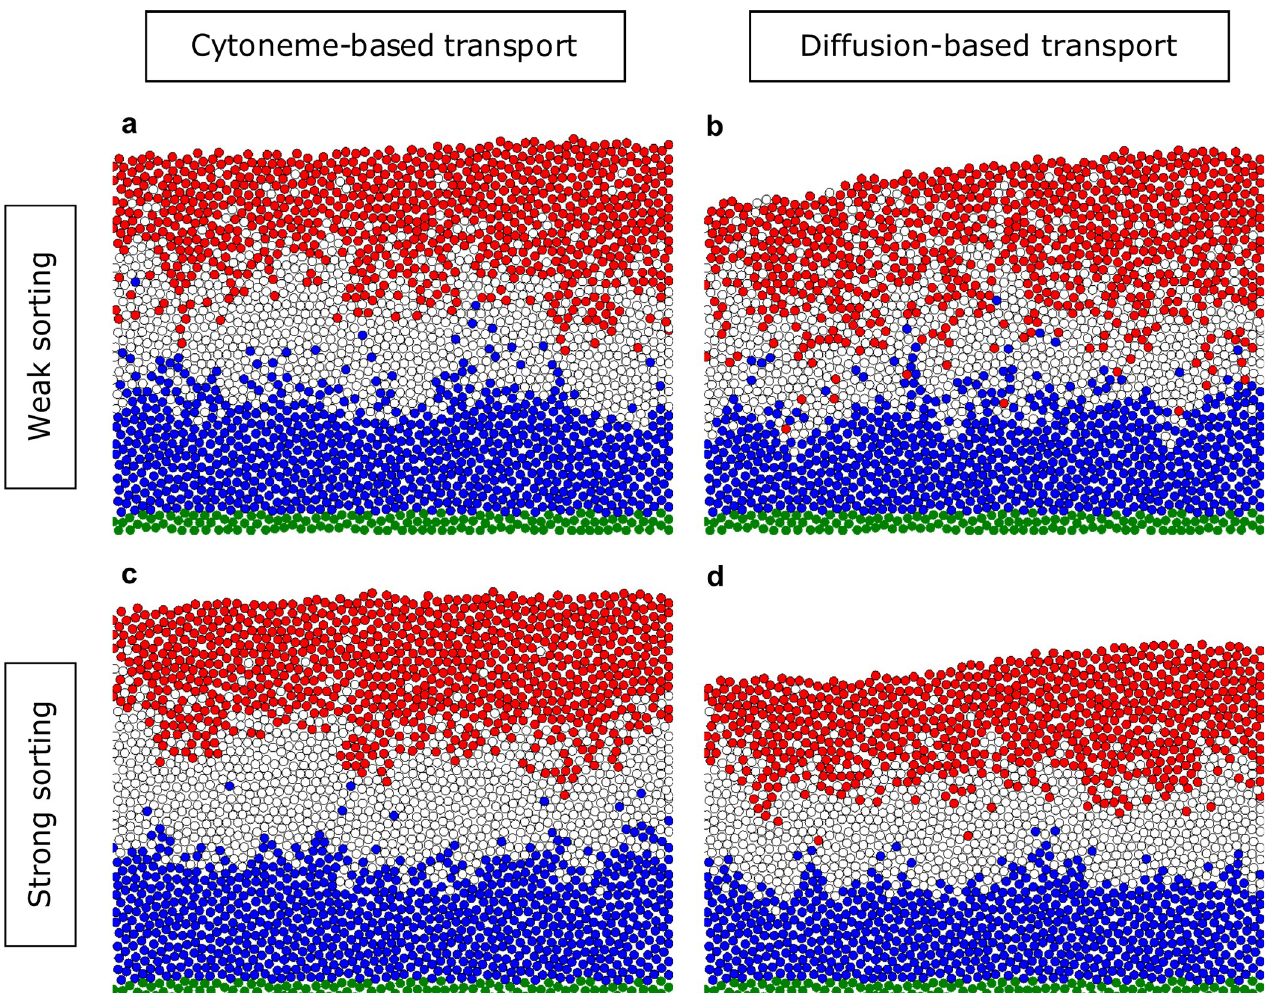
Fig 3. Boundary sharpening through directed migration. Distributions of the final cell fate at t = t TRS = 180 min in the tissue for different parameters of the cell dynamics and different transport mechanisms. Directed migration with the sorting parameter p DirMig = 0.02 is shown in a) and b) , and with p DirMig = 0.2 in c) and d) . Cell fates and coloring are as in Fig